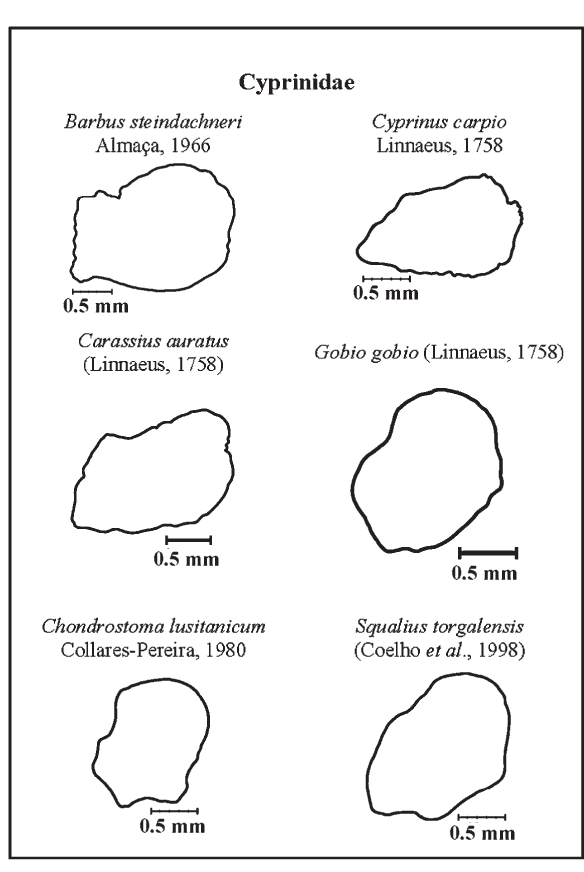
F IG . 10. – Outline of the right lapilli of several cyprinid species, illustrating the occurrence of otoliths with considerably different appearance within the same fish taxon. All outlines are represent- ed with lateral margin to the top of the page and anterior region to the